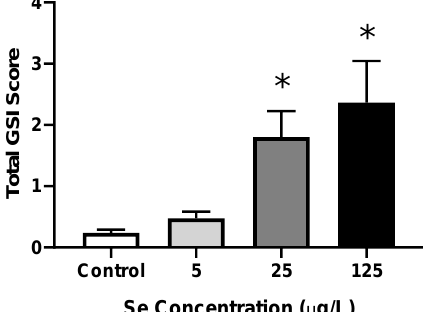
Figure 4. Mean ( ± SE) graduated severity index (GSI) scores for total deformities (sum of skeletal, craniofacial, finfold, and edema scores) in larval zebrafish exposed to increasing concentrations of L-selenomethionine (SeMet) via embryo aqueous exposure. Asterisks represent significant differences compared to the control using a one-way ANOVA followed by a Dunnett’s multiple comparisons test ( p < 0.05); n = 9–12 replicates of 20 embryos.